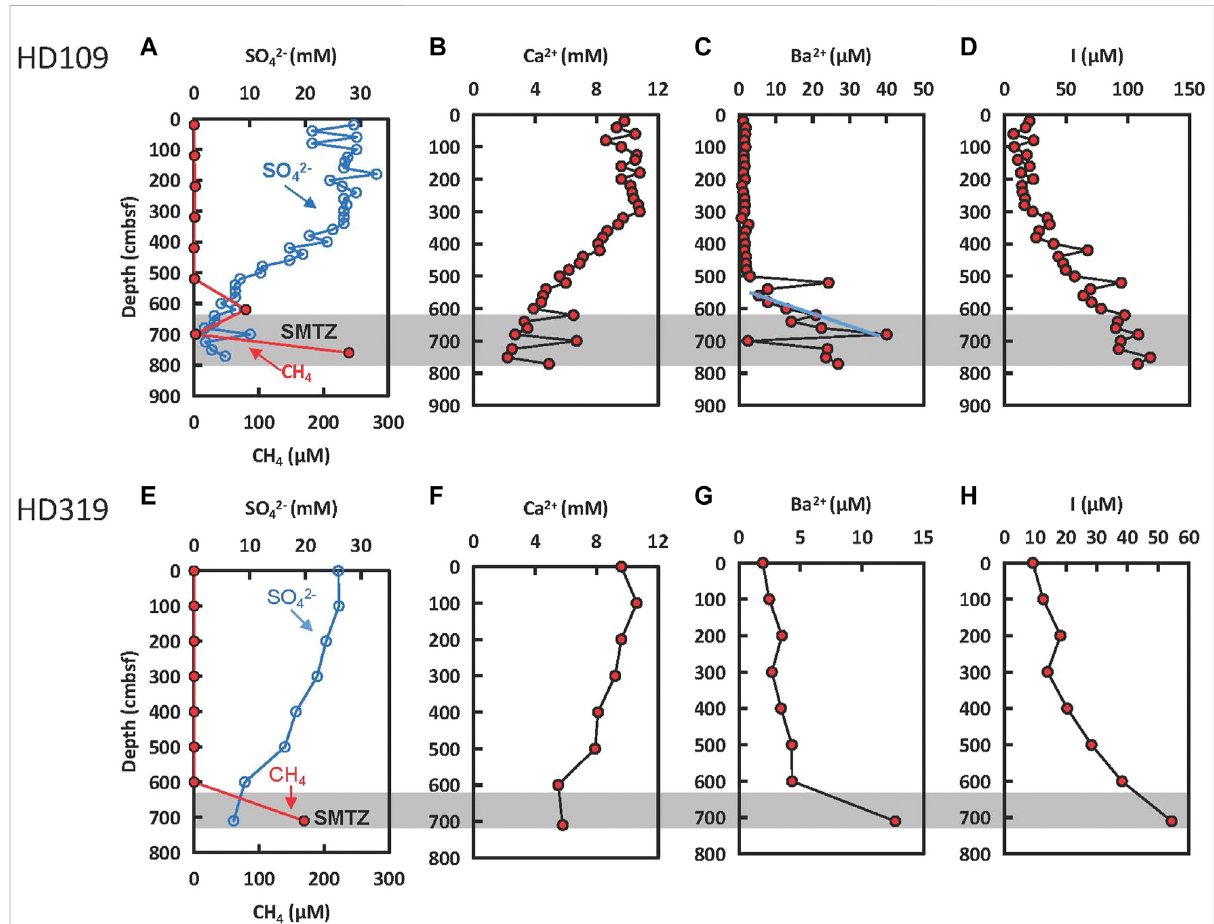
FIGURE 2 Depthpro fi les ofheadspaceCH 4 ,porewaterSO 4 2 − ,Ca 2+ ,Ba 2+ ,I- concentrationsatcores HD109 (A – D) and HD319 (E – H) . Theshadedportions of the graphs refer to the current sulfate-methane transition zones (SMTZ). The blue solid line marks the gradient used for Ba 2+ fl ux